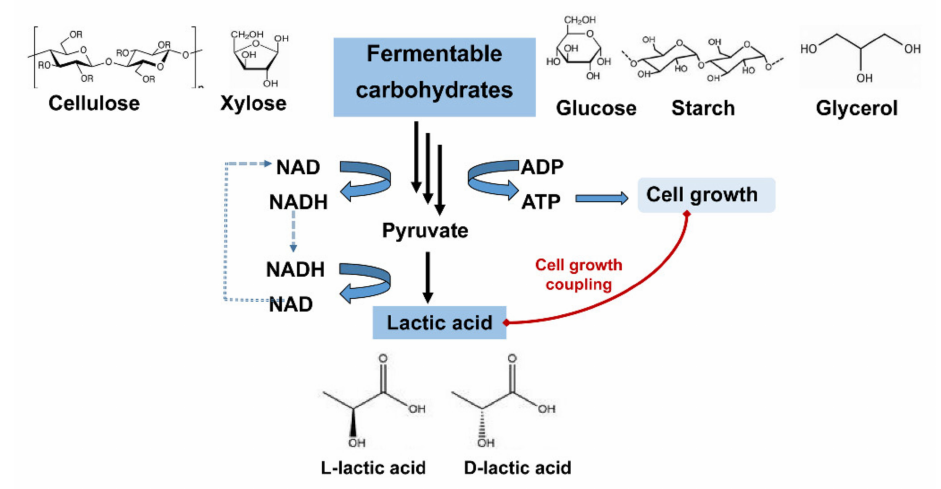
Figure 1. LA exists in two enantiomeric forms of L -lactic acid and D -lactic